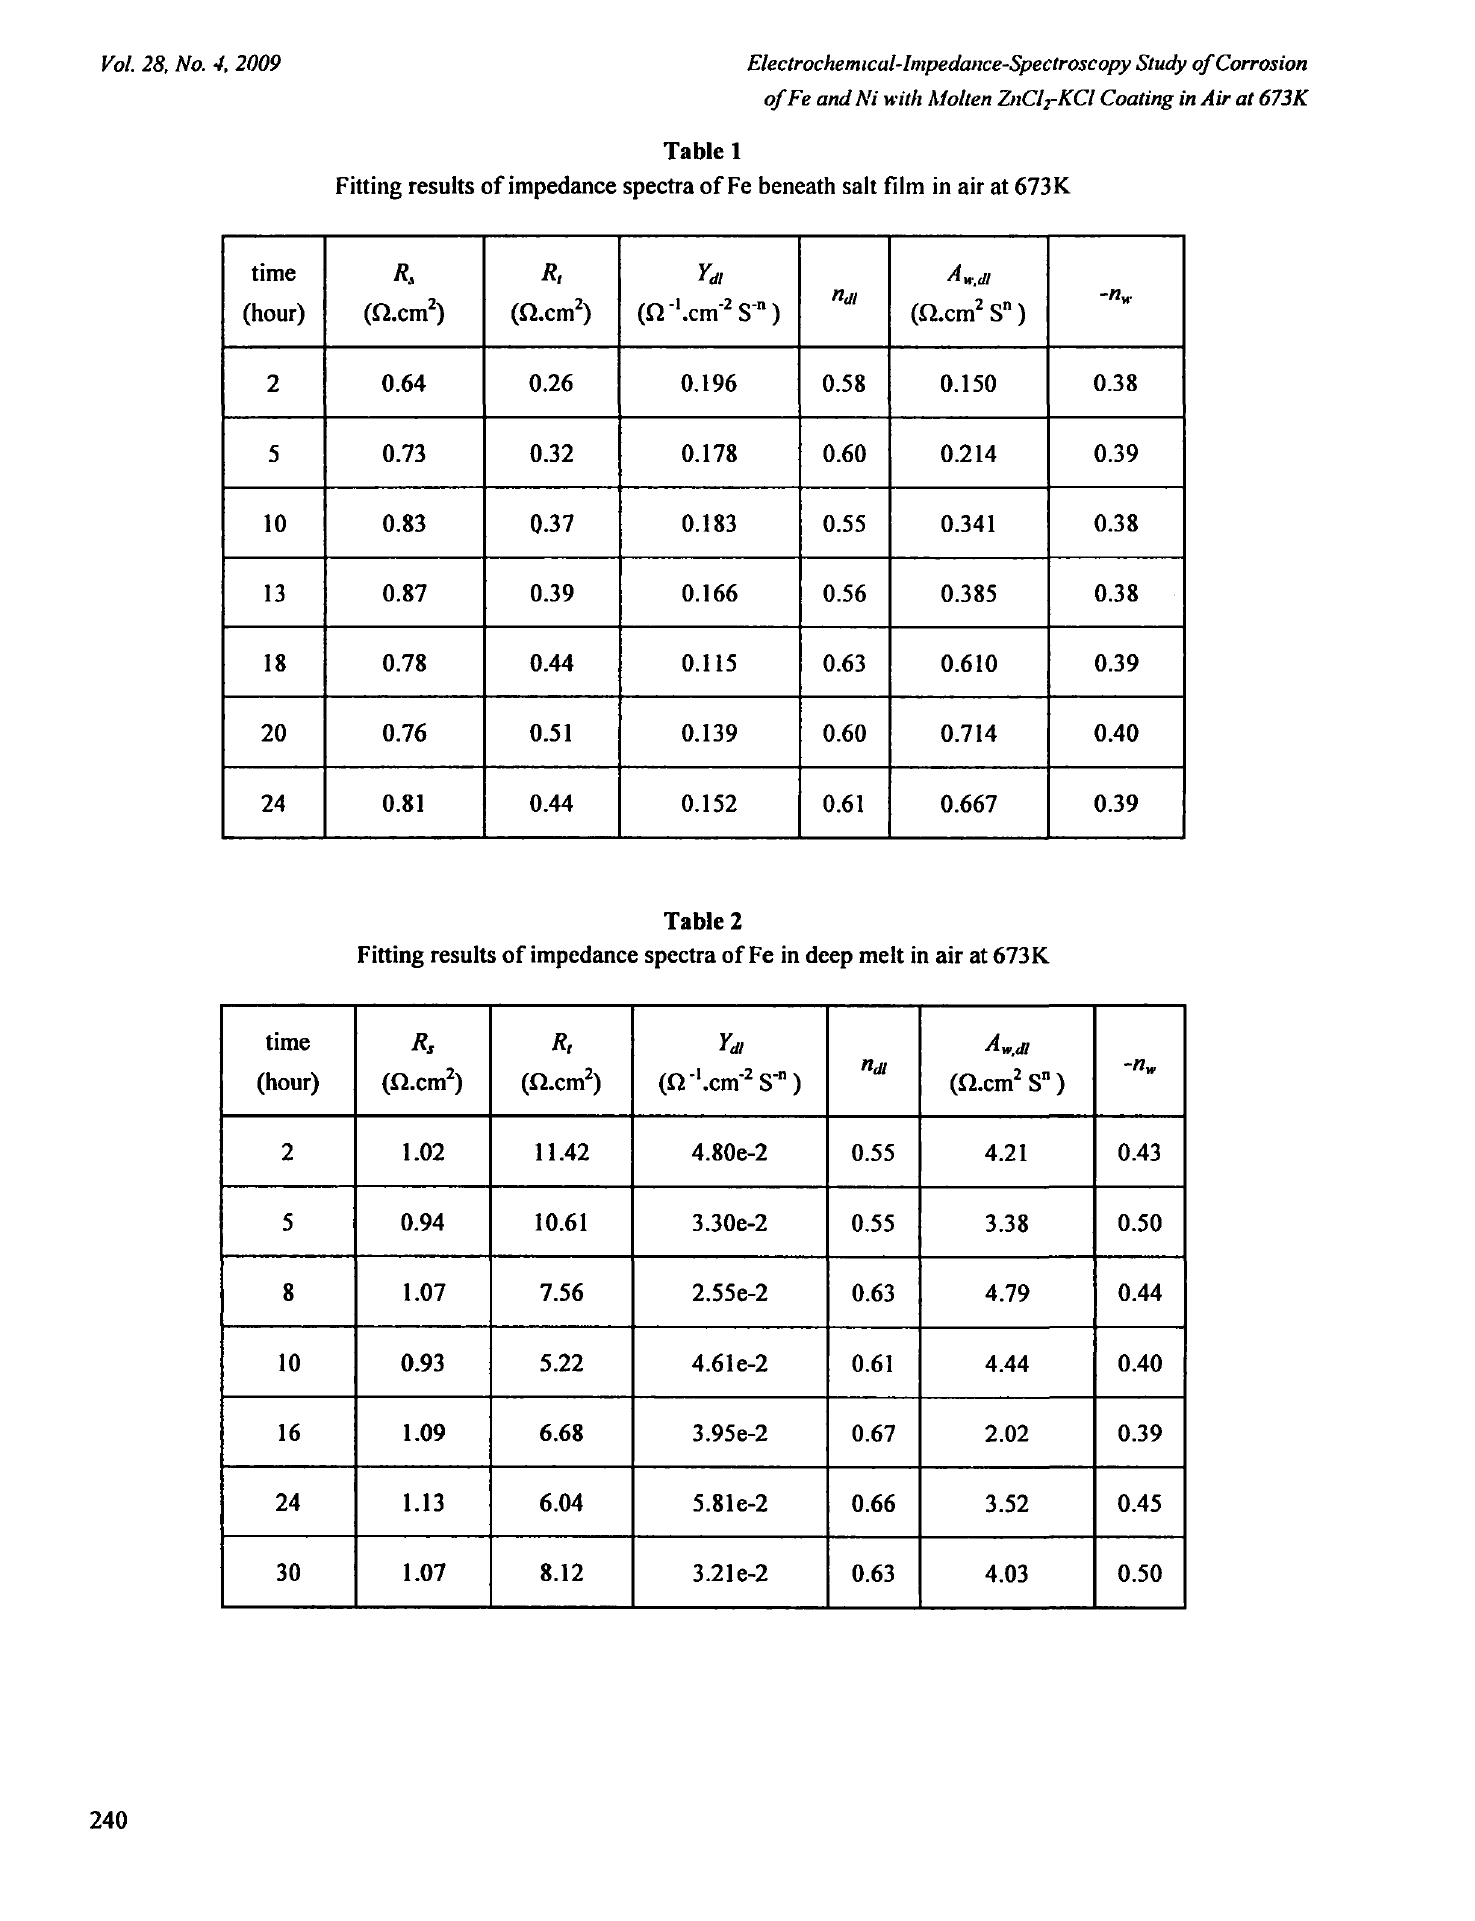
Fitting results of impedance spectra of Fe beneath salt film in air at 673K